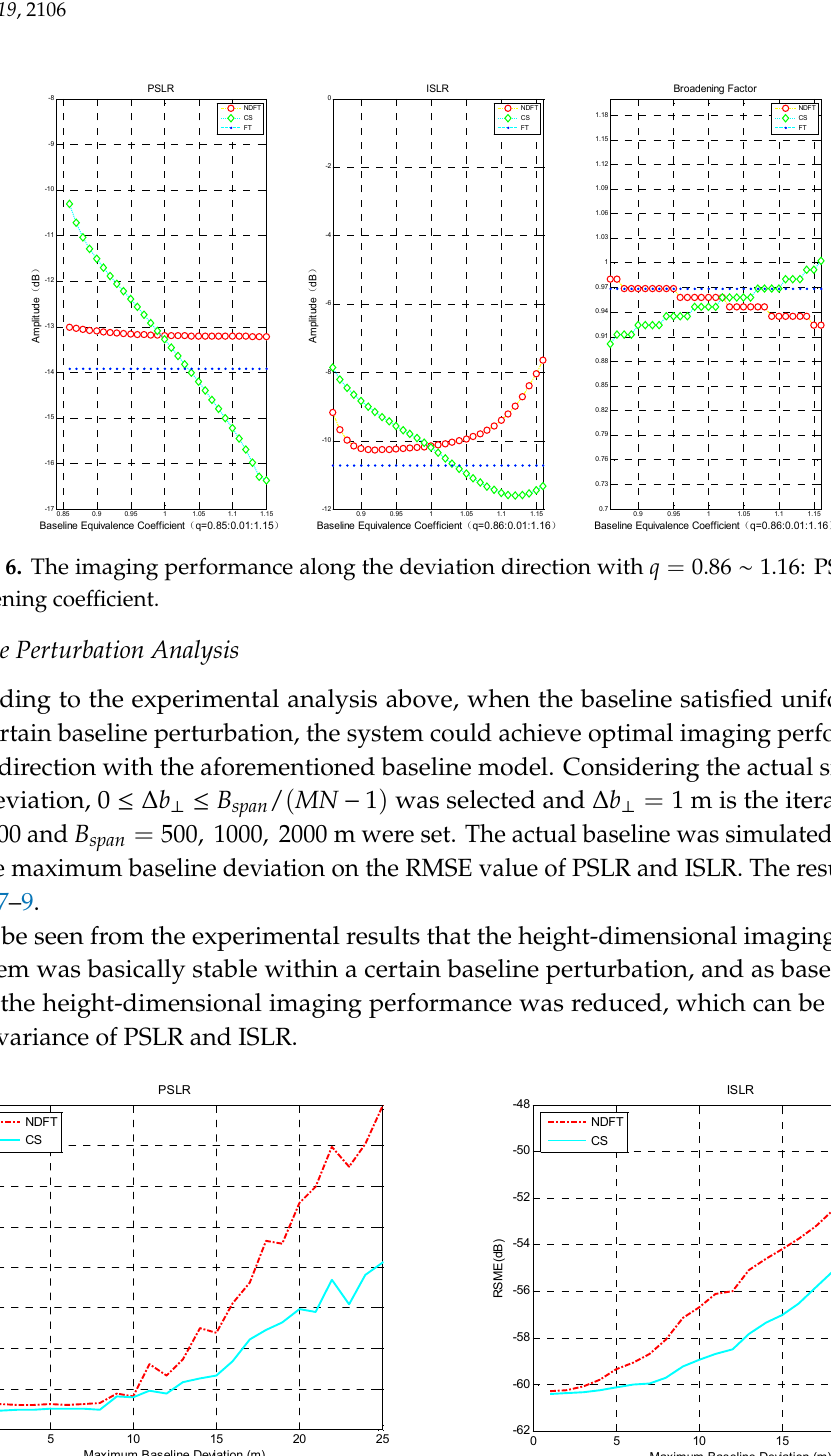
( b ) Figure 8. The imaging performance with